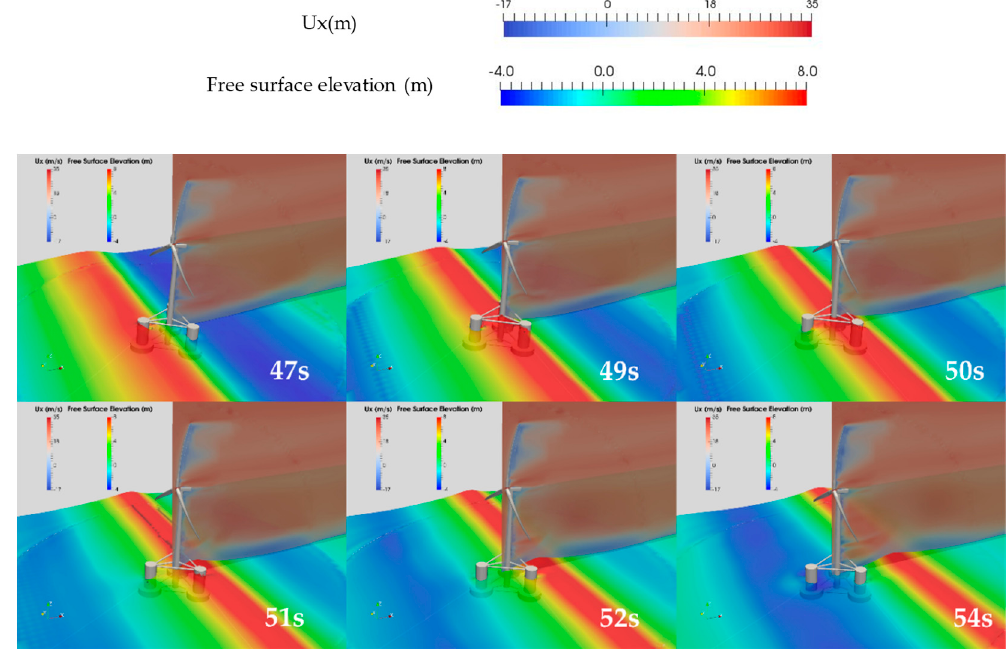
Figure 26. Free surface elevation contours and U x contour at XoZ plane around a parked FOWT near focused time.